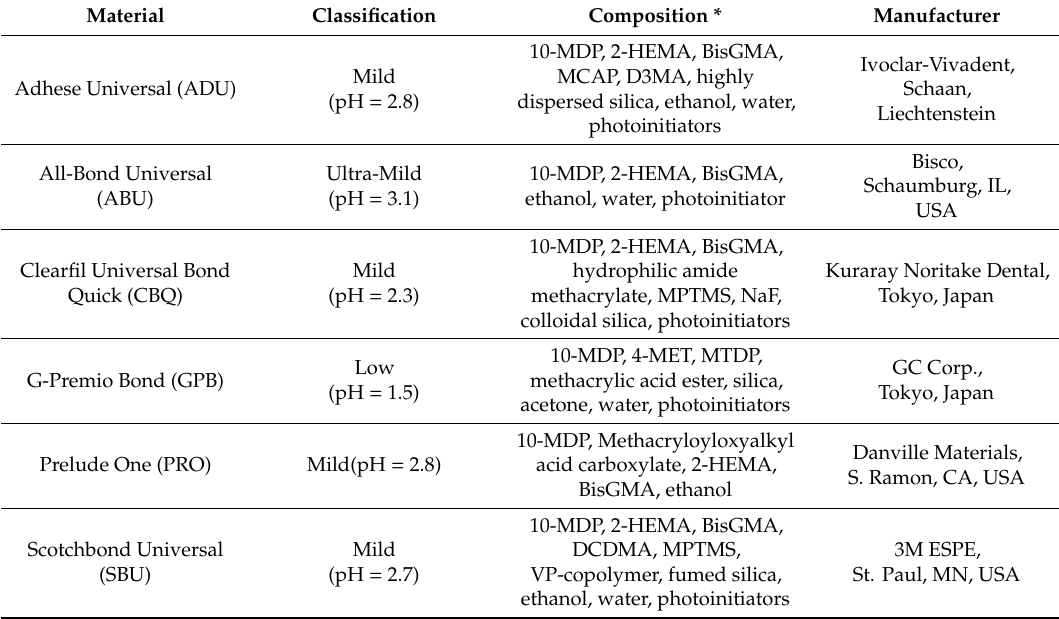
Table 1. The classification and composition of the universal adhesives